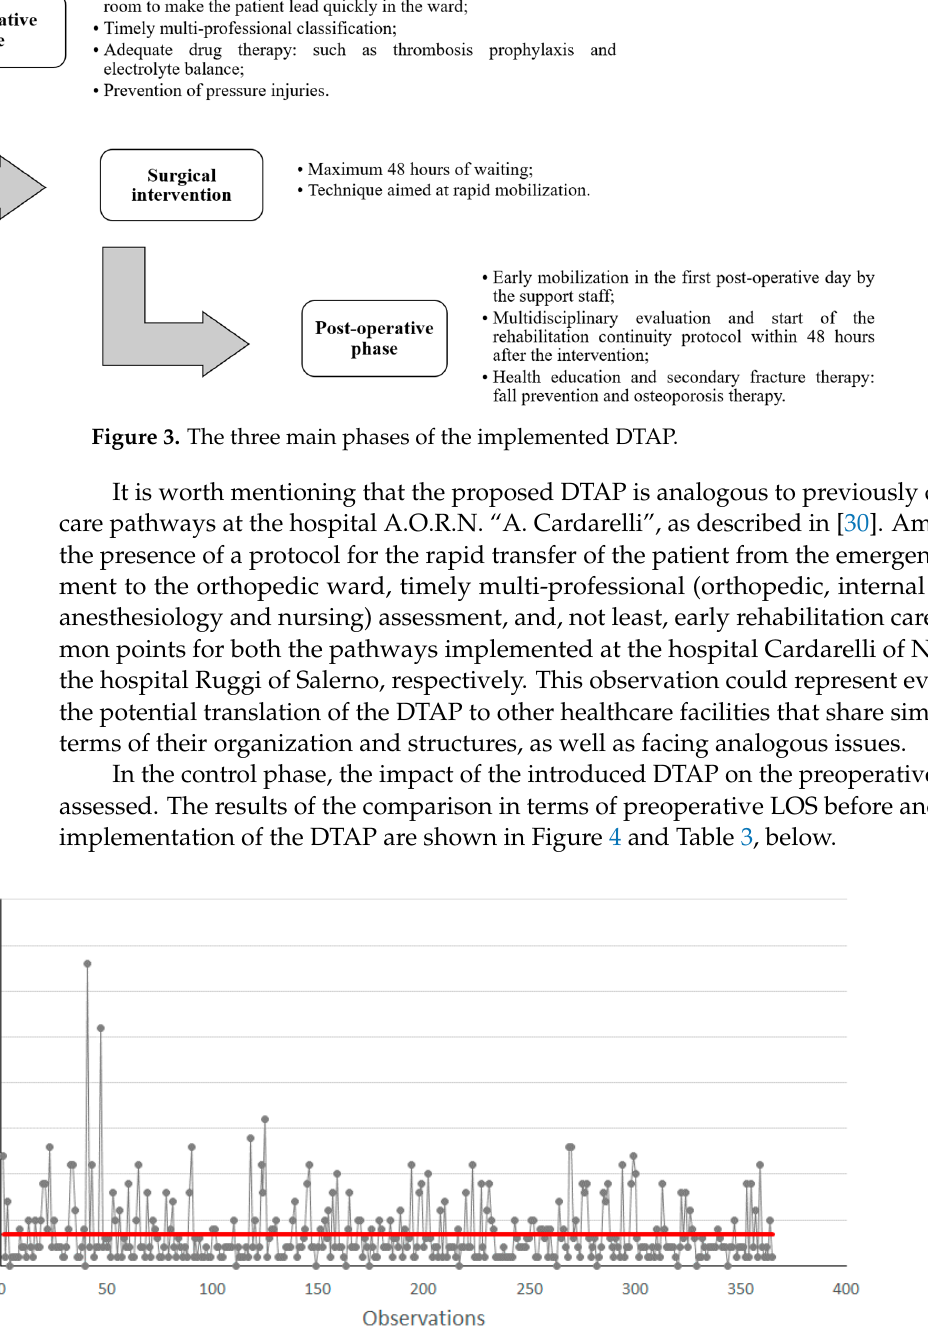
Figure 3. The three main phases of the implemented DTAP.